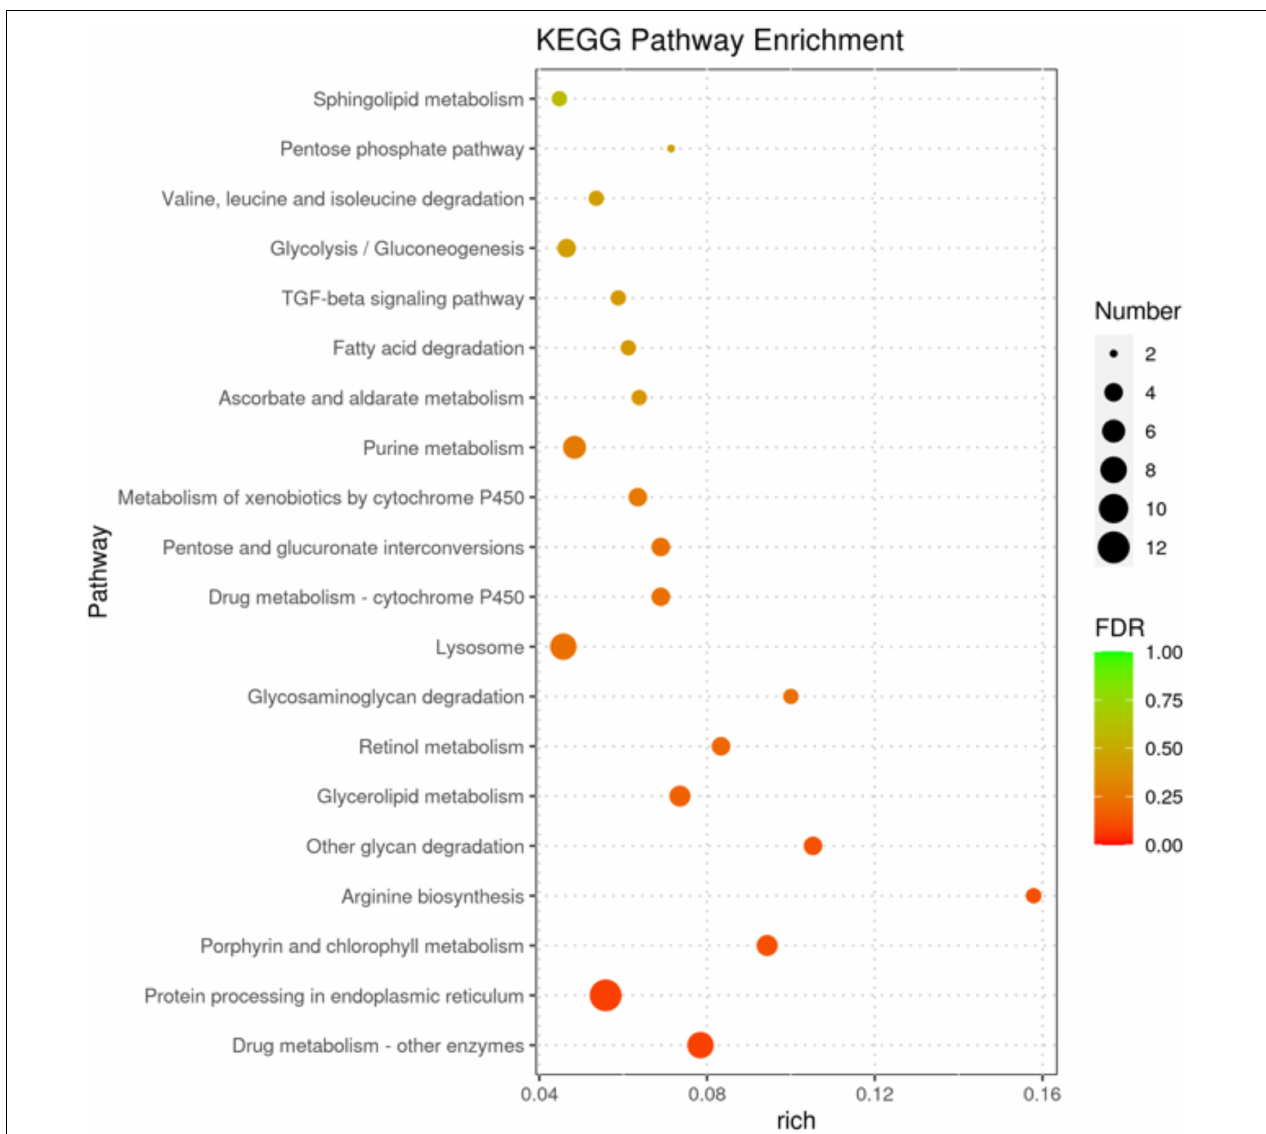
FIGURE 5 | Statistics of KEGG pathway enrichment